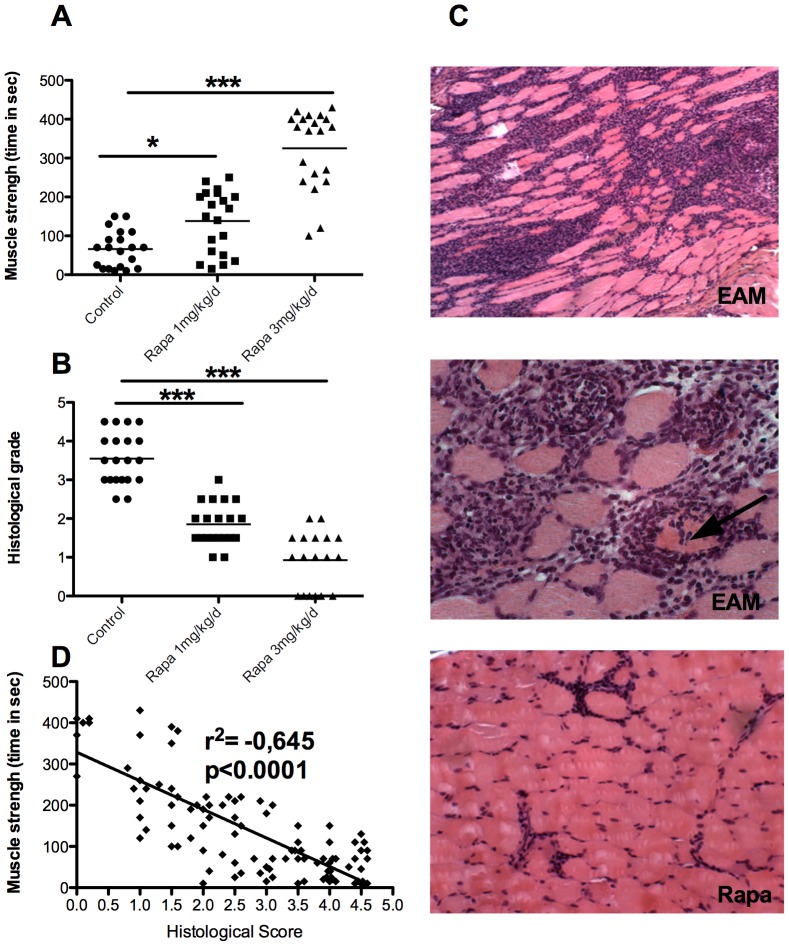
Preventive administration of rapamycin permits to decrease severity of EAM.A: strength (time to fall) improvement in rapamycin-treated mice. B: gastrocnemius, quadriceps, and triceps muscle inflammatory infiltrates evaluated by histological grading after hematoxylin-eosin staining as illustrated in C. C: the first two upper images represent a gastrocnemius section of an EAM mouse untreated with a histological score of 4 (HE, ×20). The middle picture also shows an invaded/tunnelized fiber (arrow, HE, ×40). The third image panel represents a gastrocnemius section of a EAM mouse treated with 3 mg/kg/day of rapamycin, displaying a histological score of 1 (HE, ×20). D: correlation between muscle strength (time to fall) and histological grade of inflammation.